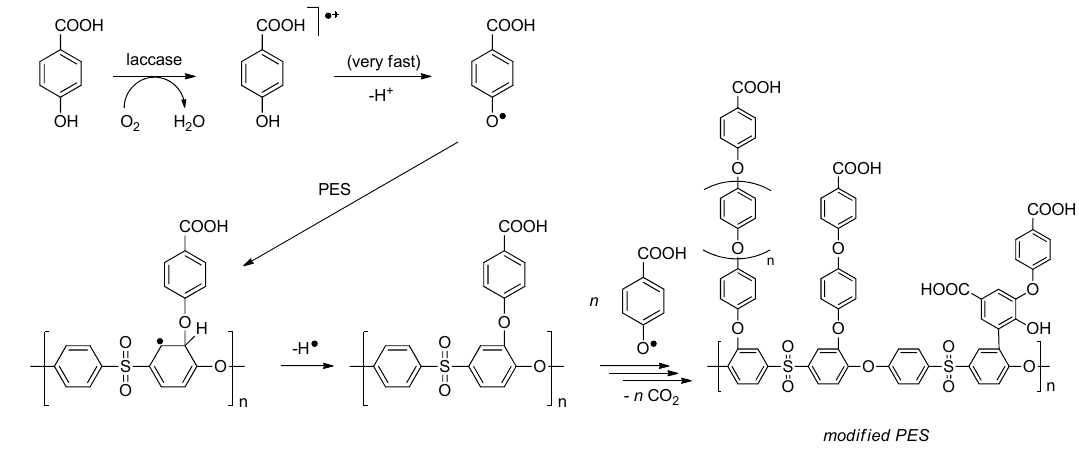
Figure A1. Tentative mechanism for the formation of reactive 4-hydroxybenzoic acid radicals by laccase and grafting of the radicals to PES